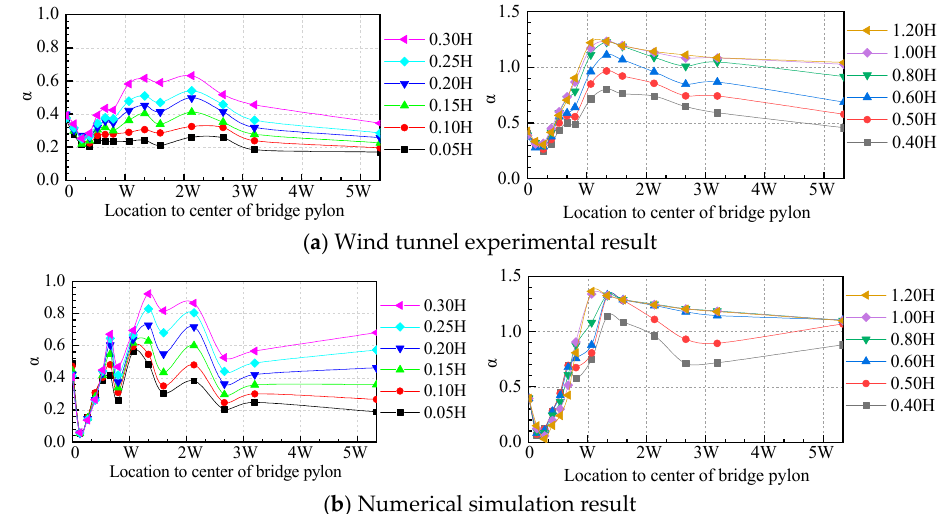
Figure 15. Wind speed coefficient at downstream main lane in C1 condition.